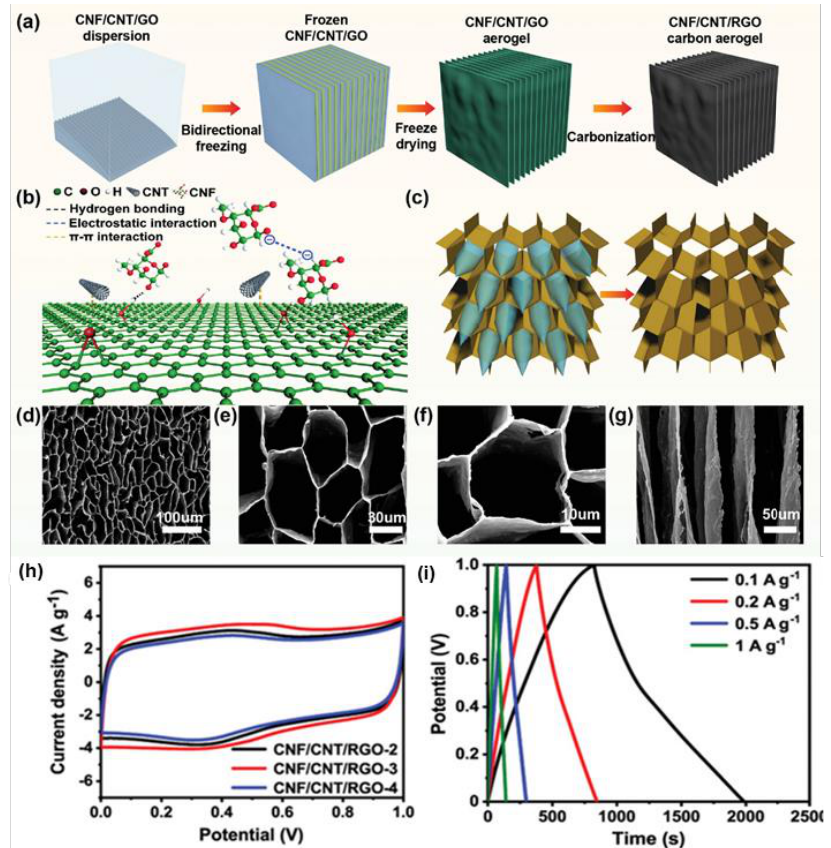
Figure 9. ( a ) Illustration for CNF/CNT/RGO carbon aerogels fabrication. ( b ) The schematic diagram of the interaction between CNF, CNT, and RGO. ( c ) Schematic diagram of ice crystal growth mech- anism. ( d − f ) Top-view and ( g ) side-view SEM images of CNF/CNT/RGO − 3 carbon aerogel. ( h ) CV curves of CNF/CNT/RGO − 2, CNF/CNT/RGO − 3, and CNF/CNT/RGO − 4 at 2 mVs − 1 . ( i ) GCD curves of CNF/CNT/RGO − 3 carbon aerogel. Reproduced with permission [162] Copyright © 2022, Ad- vanced Functional Materials.